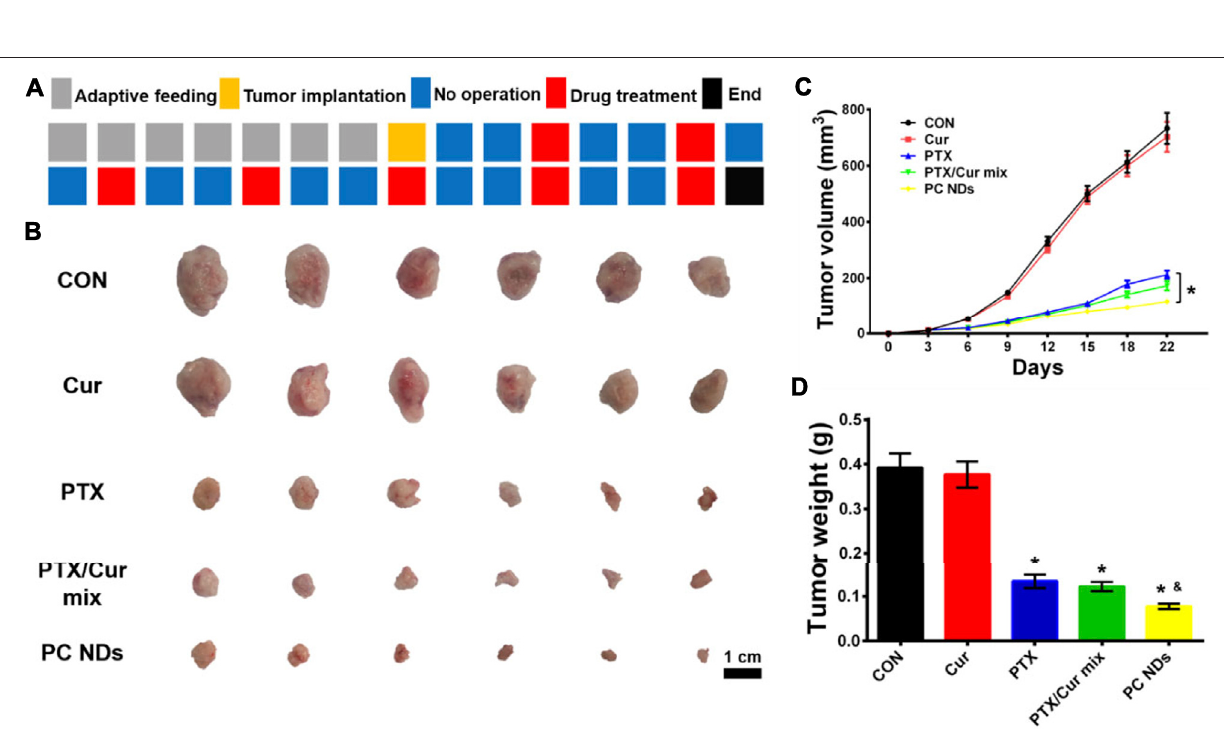
Frontiers in Bioengineering and Biotechnology |